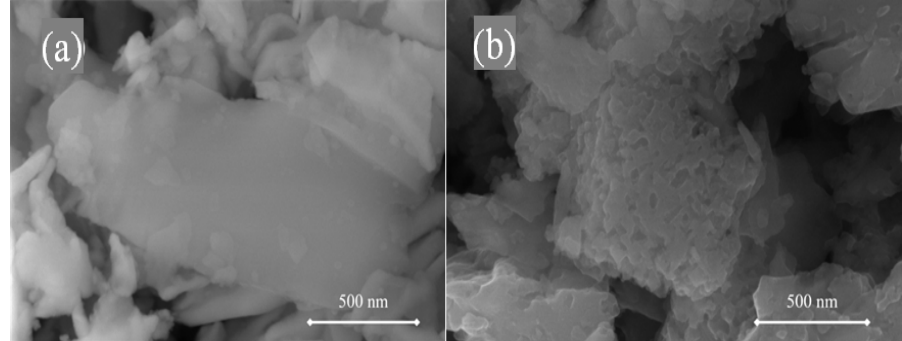
Figure 1. SEM images of diamond wire saw silicon powder (DWSSP), ( a ) and porous silicon ( b ). Fourier transform infrared spectroscopy (FT-IR) and X-ray photoelectron spectroscopy (XPS) were used to characterize functional groups on the surface of organic functionalized porous silicon, and the infrared spectrum of GTS-NPSi and TEPA-GTS- NPSi was obtained as shown in Figure 2.